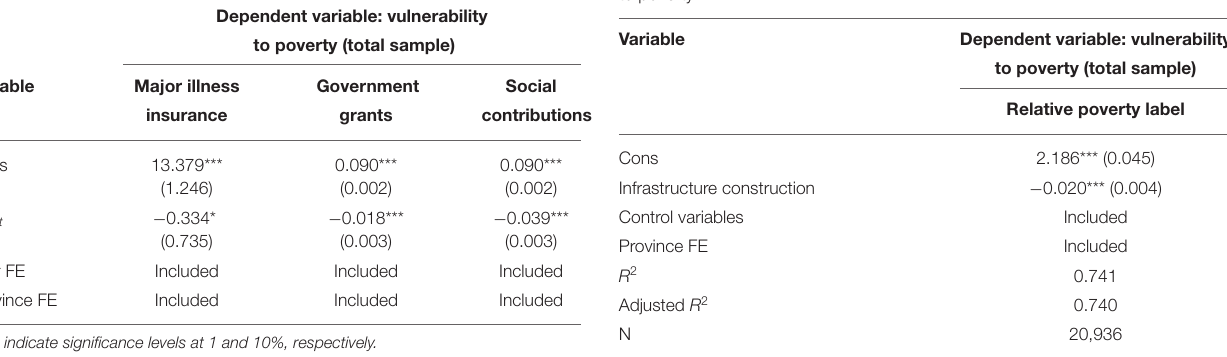
TABLE 9 | The poverty reduction effect of major illness insurance. TABLE 10 | Test results of the effect of infrastructure construction on vulnerability to